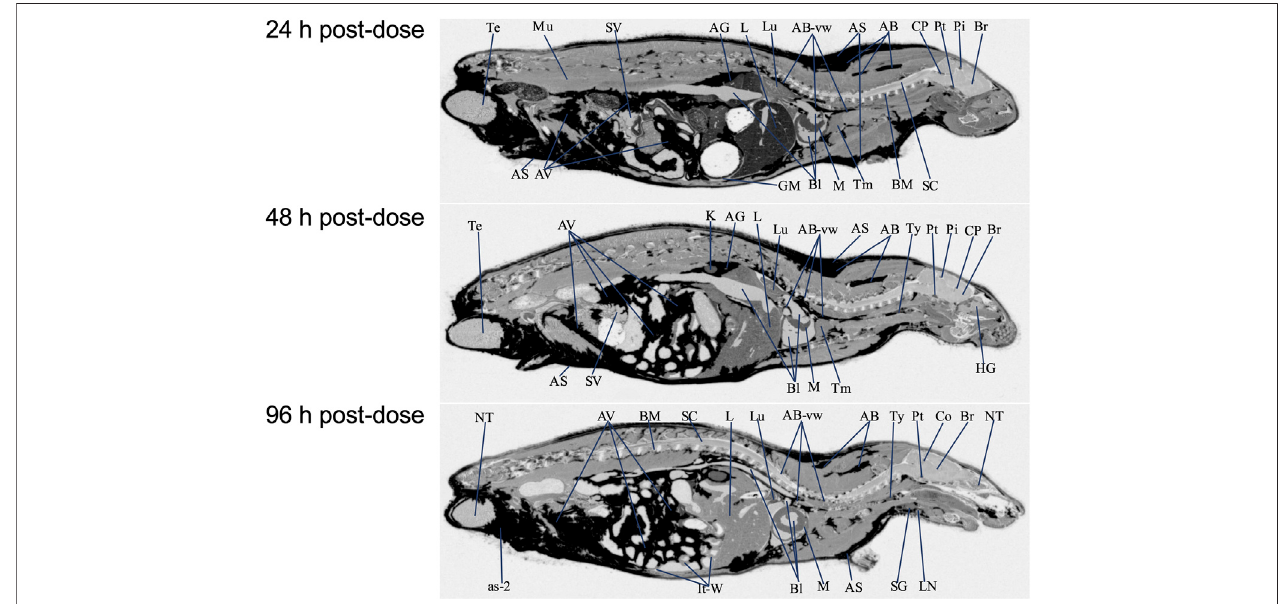
FIGURE4| Selectedautoradiographyimages(24,48,and96 hpost fi naldose)oftissuedistribution ofinthewholeratbodyafter15dailyoraldosesat100 mg/kg [ 14 C]PPI-1011. The abbreviations are: AB,adipose brown; AS, adipose subcutaneous; AV,adipose visceral;AB-vw, adipose brown:vessel wall; as-2,adipose-soaked: epididymis;AG,adrenalgland;Bl,blood;BM,bonemarrow;Br,brain;Co,colliculus;CP,choroidplexus;GM,gastricmucosa;HG,harderiangland;It-W,intestinaltract wall;K,kidney;L,liver;LN,lymphnode;Lu,lung;M,myocardium;Mu,muscle;NT,nasaltubinates;Pi,pinealgland;Pt,pituitarygland;SC,spinalcord;SG,salivary gland; SV, seminal vesicles; Te, testis; Tm thymus; Ty, thyroid.